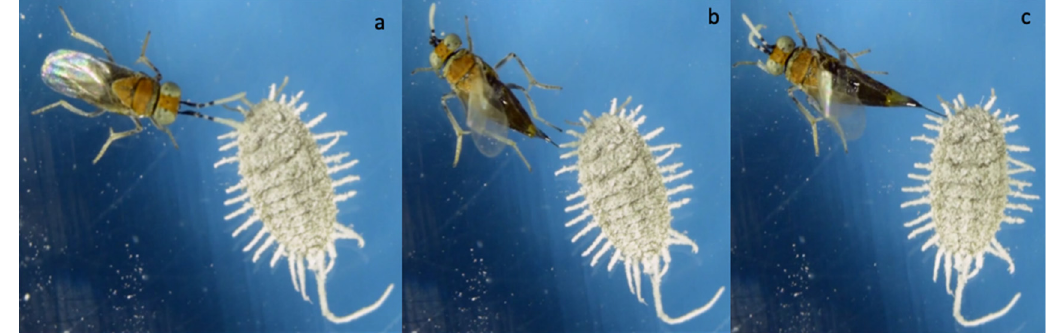
Figure 2. Key behavioral displays performed by Anagyrus vladimiri during host searching and parasitization on Pseudococcus comstocki : ( a ) antennal tapping, ( b ) probing, and ( c ) oviposition.